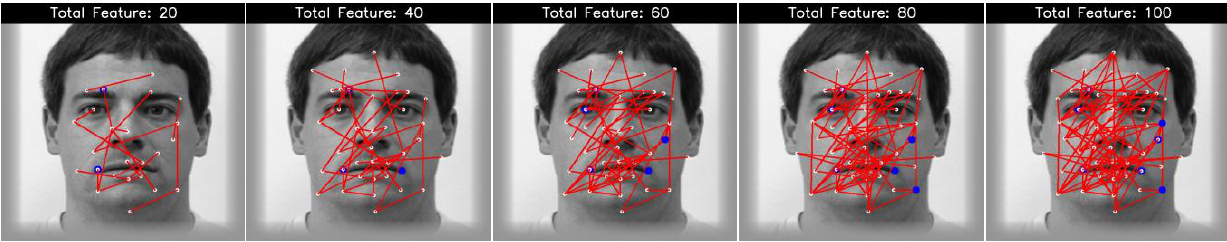
Figure 5. The first few (20, 40, 60, 80, and 100) features selected using multi-class AdaBoost. A blue dot indicates a feature vector extracted only from that landmark tracking result, as the expression evolves over time; whereas a red line connecting two landmarks indicates the feature vector extracted from that pair of landmarks tracking result, as the expression evolves over